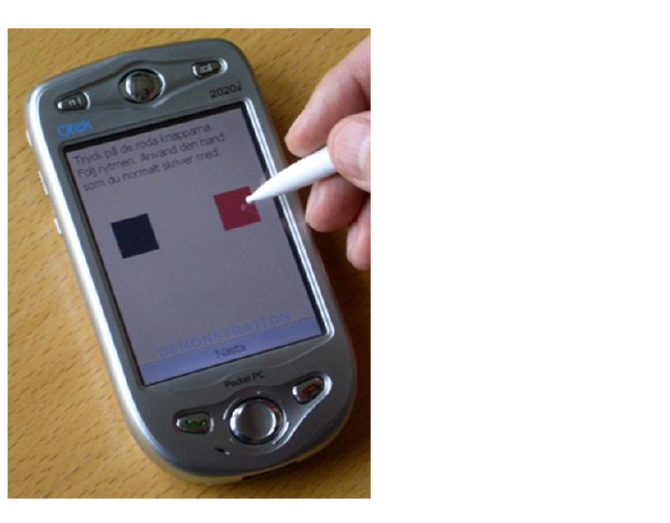
Figure 1. Illustration of the alternating tapping test using the telemetry